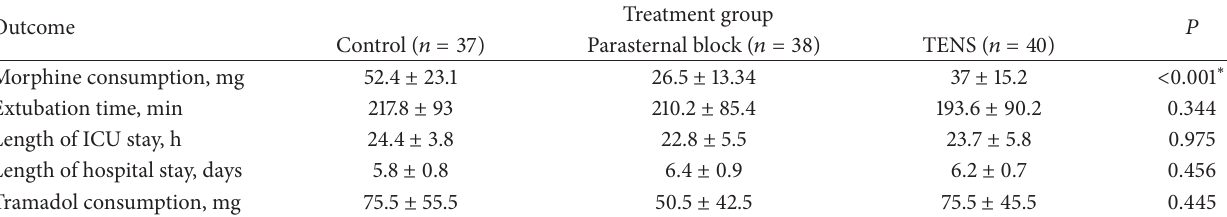
Figure 1: Changes in the visual analogue scale (VAS) scores in the control, parasternal block, and the transcutaneous electrical nerve stimulation (TENS) groups within the first 24 h postoperatively ( 𝑃 < 0.001 for 4h, 5h, 6h, 7 h, and 8h). Table 2: Postoperative outcomes (0 h to 24